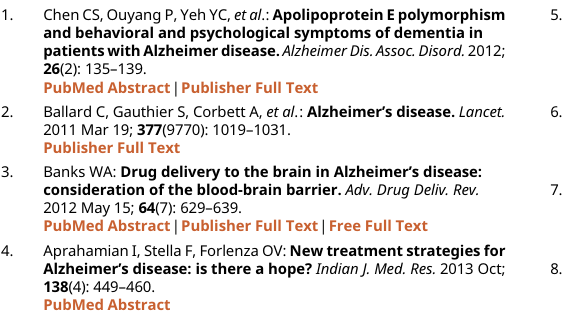
Figshare: Data file 01 - In vitro evaluation data, https://doi.org/10.6084/m9.figshare.21484905.v1. 88